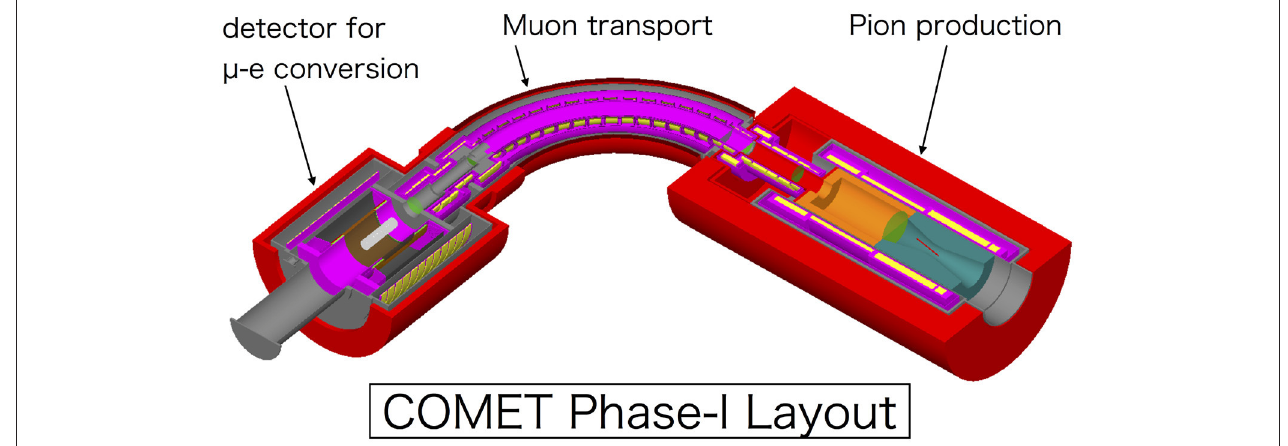
FIGURE 2 | The layout of detectors and beamlines of COMET Phase-I experiment. The pion capture solenoid system with proton target in the center (right part), the muon transport solenoid system (middle part), and the CyDET detector system with muon stopping target in the center (left part) are shown. See the text for more description.